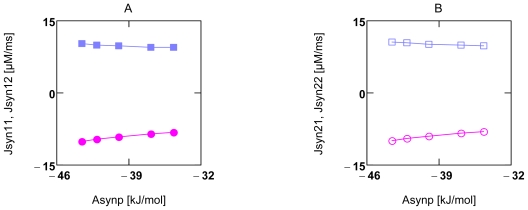
NET analysis of JSY as a two-flux-system. JSYp and JSYh are both uncoupled by λsp = 0.02 λsh = 0.04 (qs = 0.971, Zs = 0.99). A: (filled circles) Jsyn11, (filled squares) Jsyn12, both versus ASYP (Asynp); B: (open circles) Jsyn21, (open squares) (Jsyn22), both versus ASYP (Asynp); C: (red diamonds) Jsynp, (green diamonds) Jsynh, both versus ASYP (Asynp); D: efficiency versus force ratio (ASYP| ASYh), (open circles) results from simulation; (line) analytical results according to (8l); E: normalized dissipation function versus reduced force ratio x, (filled circle) result from simulation, (open circle) result from simulation, but at xmax, (line) analytical curve according to A20a; F: normalized power output versus x, (filled circle) result from simulation, (line) analytical curve according to A20b; SIMOPPyr